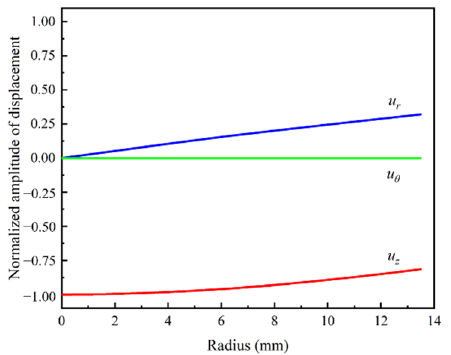
Figure 3. Displacement distribution of L(0, 1) modal UGWs in cylindrical rod at 60 kHz.